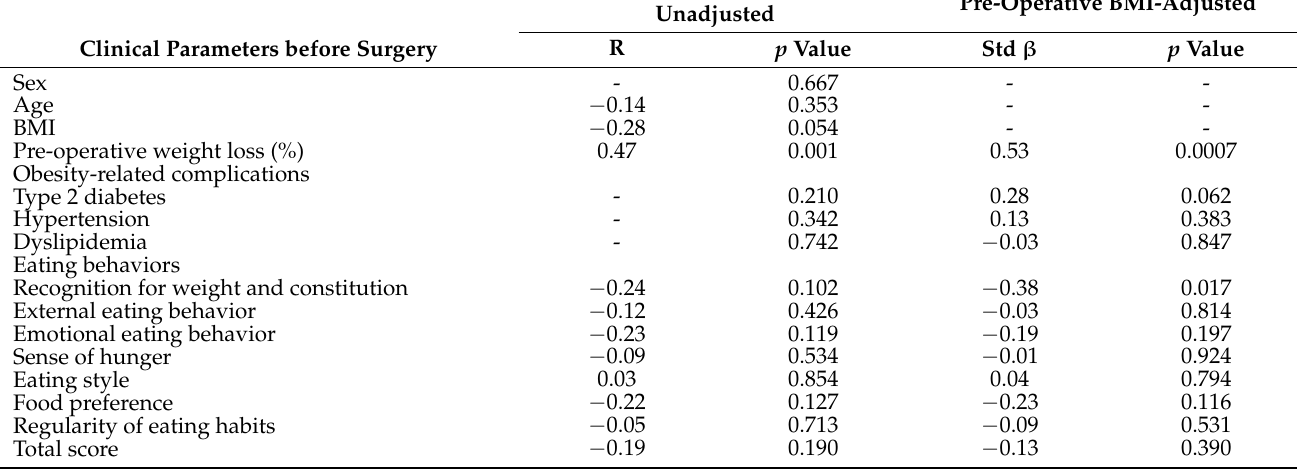
Table 3. Correlations between clinical parameters before surgery and %EWL at 12 months af- ter surgery.